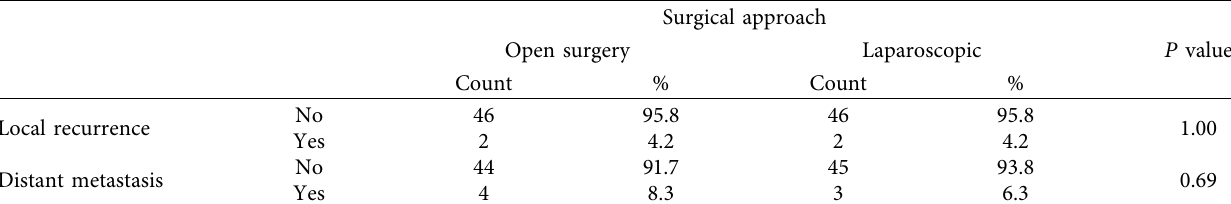
Table 5: Recurrence (local and distant) according to the surgical